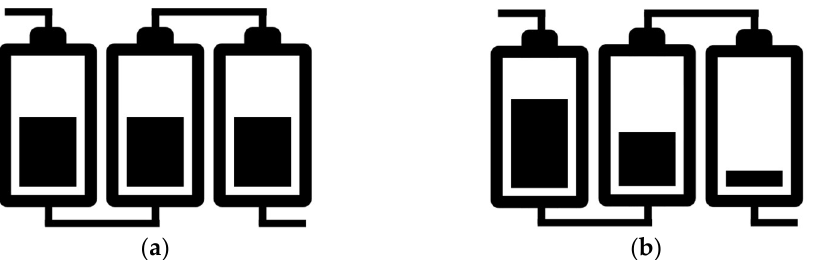
Figure 1. ( a ) Battery cells having a uniform voltage; ( b ) battery cells having a non-uniform voltage.